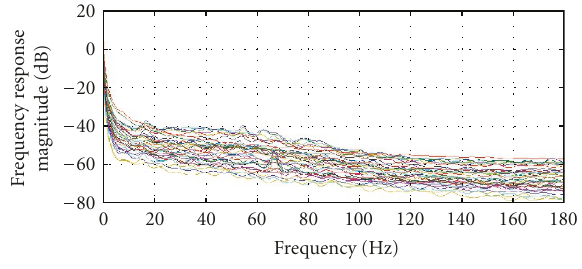
Figure 6: Frequency response magnitudes of 32 segments of the time-varying AR filters for the baseline wander noises of the NSTDB. This figure illustrates how the AR filter responses are evolv- ing in time.